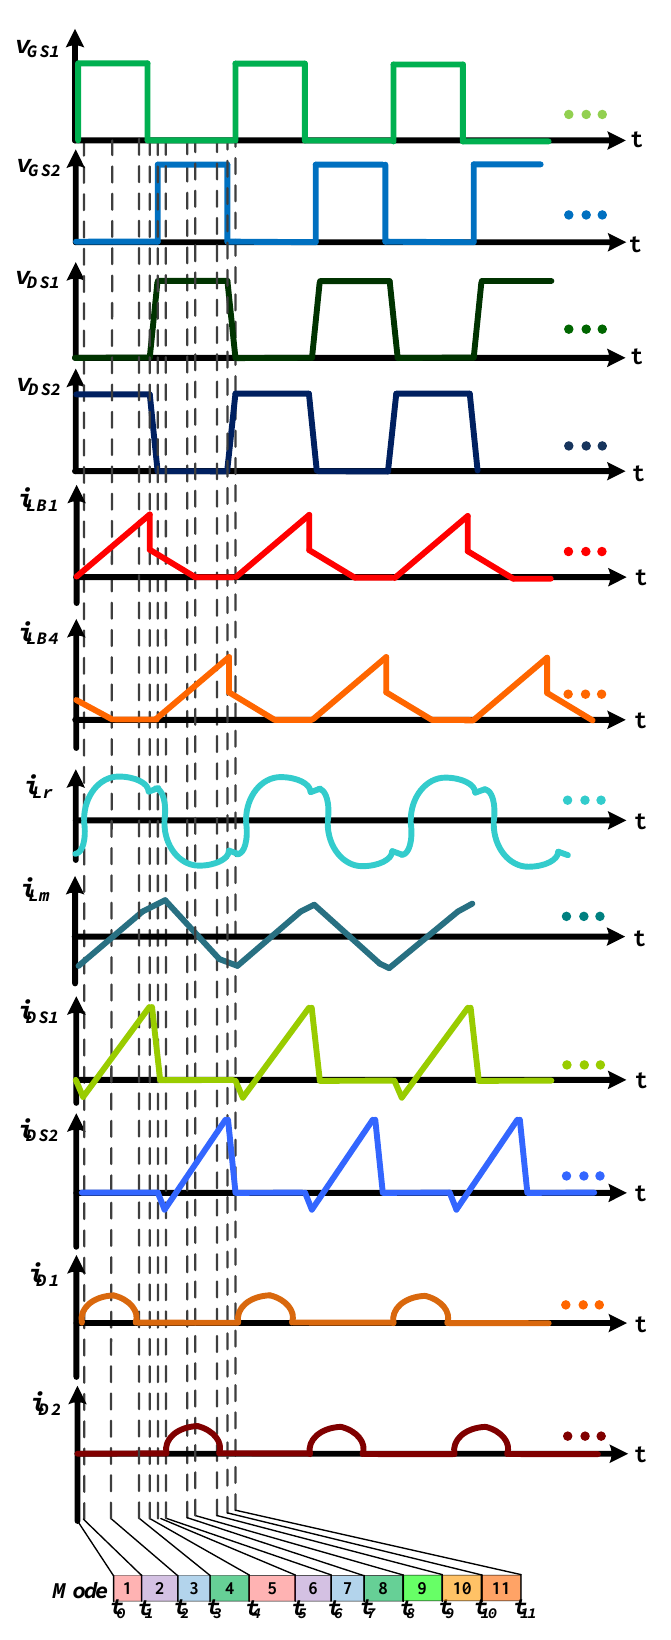
Figure 5. Key waveforms of the presented LED driver for streetlight applications.